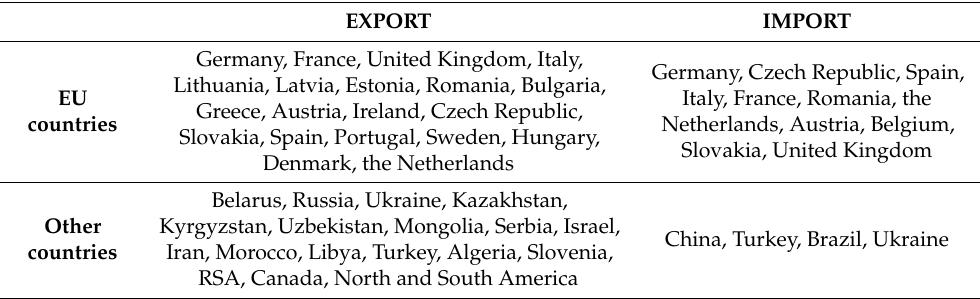
Table 1. Directions of exports and imports in the period 2012 to 2014 in the ten investigated firms representing the Wielkopolska